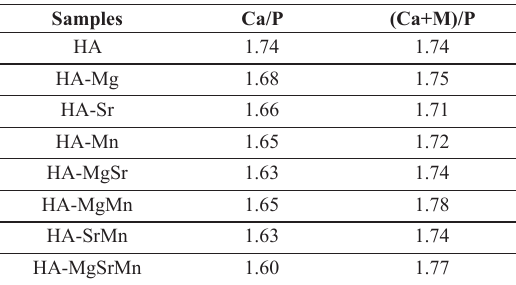
Table 1. Ca/P and (Ca+M)/P ratios obtained from WDXRF. M = Mg, Sr and/or Mn.